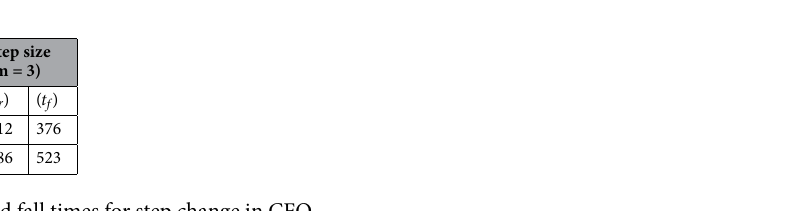
Table 1. Rise times and fall times for step change in CFO.